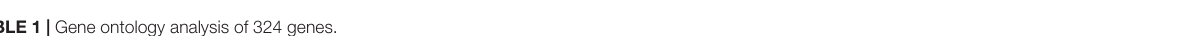
TABLE 1 | Gene ontology analysis of 324